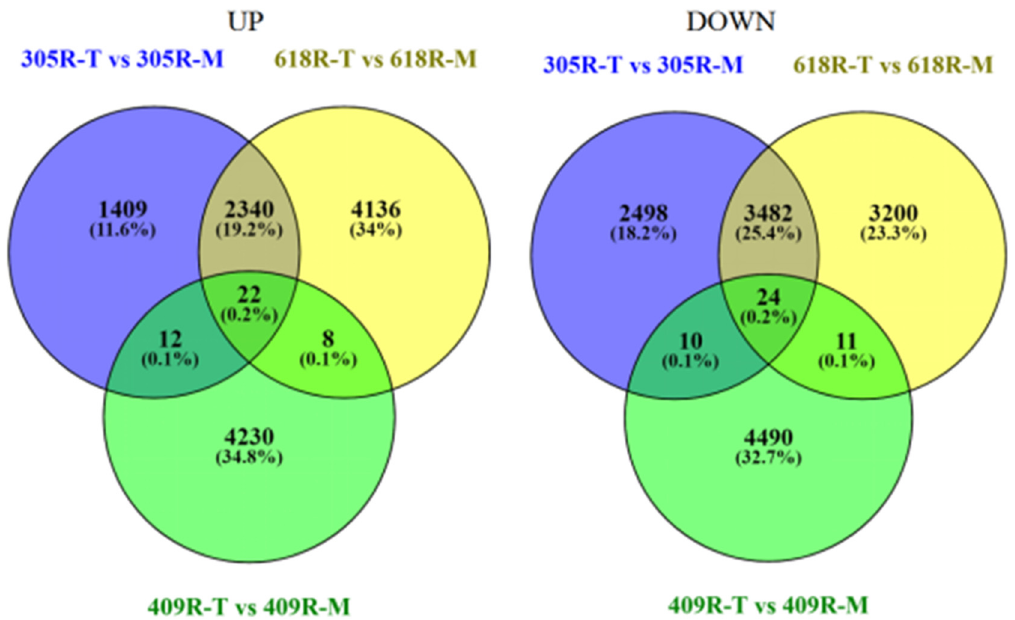
Figure 1. Number of differentially expressed genes that were up- and down-regulated based on a comparison among the resistant lines.